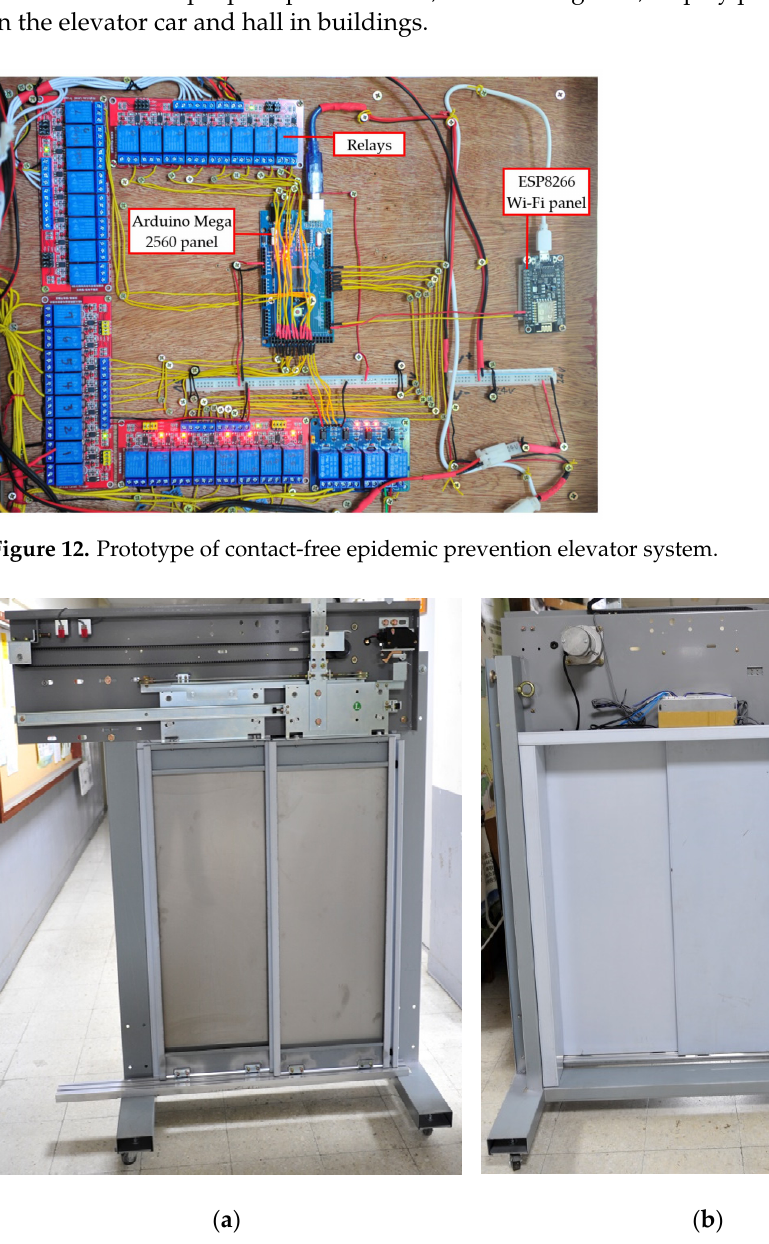
Figure 13. Elevation view of the elevator before installation. ( a ) Elevator car; ( b ) elevator hall.